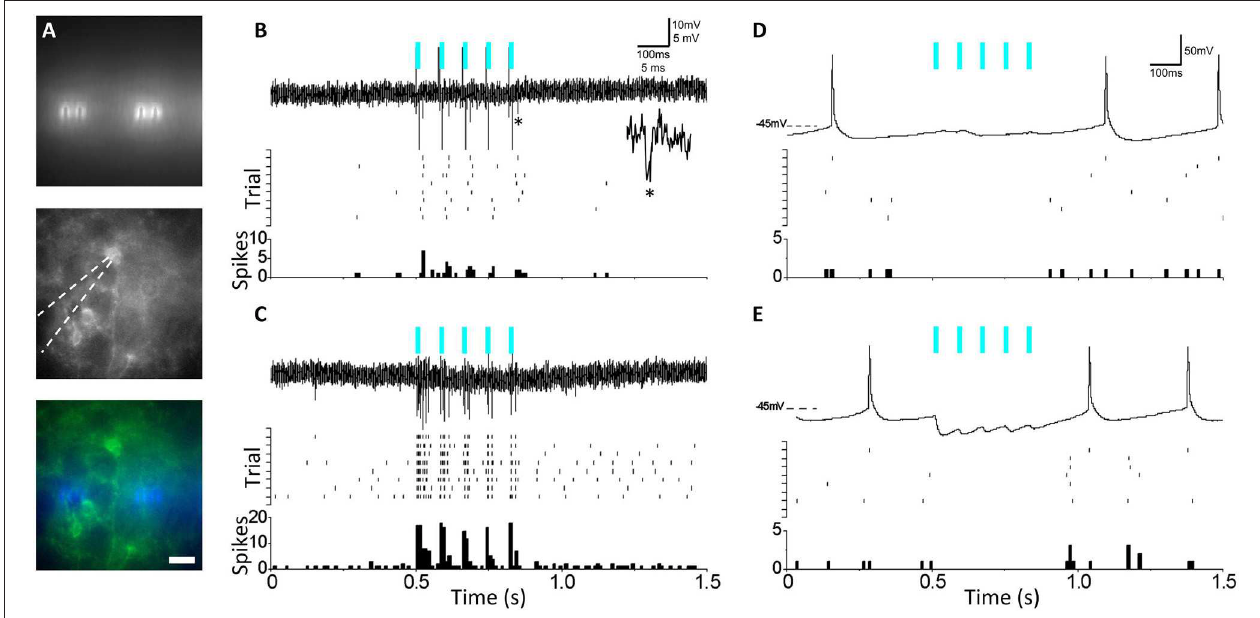
FIGURE 6 | (A) Top: Activation of micro-LED ( µ LED) array embedded beneath recording chamber prior to slice positioning. Center: Targeted recordings from fluorescent ChR2-expressing SST interneurons above array. Bottom: overlay. (Scale 22 µ m). (B) Top: Juxtacellular recording showing µ LED activation (blue bars) of = channelrhodopsin-expressing SST interneuron. *Shown as inset, single µ LED evoked spike. Center: Multi-trial spike rasters from the same neuron aligned to µ LED activation. Bottom: Peri-stimulus time histograms (PSTH) from the above. (C) As in (B) but with full-field LED activation of SST interneuron (lower trace) (D) Top: As in (B) but for whole-cell current clamp recording of neocortical pyramidal neuron showing feedforward inhibition during µ LED activation of SST interneurons, with suppression of spontaneous pyramidal neuron firing activity. (E) As in (D) but using full-field LED activation. IPSPs are larger than with µ LED activation and visible as inward currents as V rest >E Cl